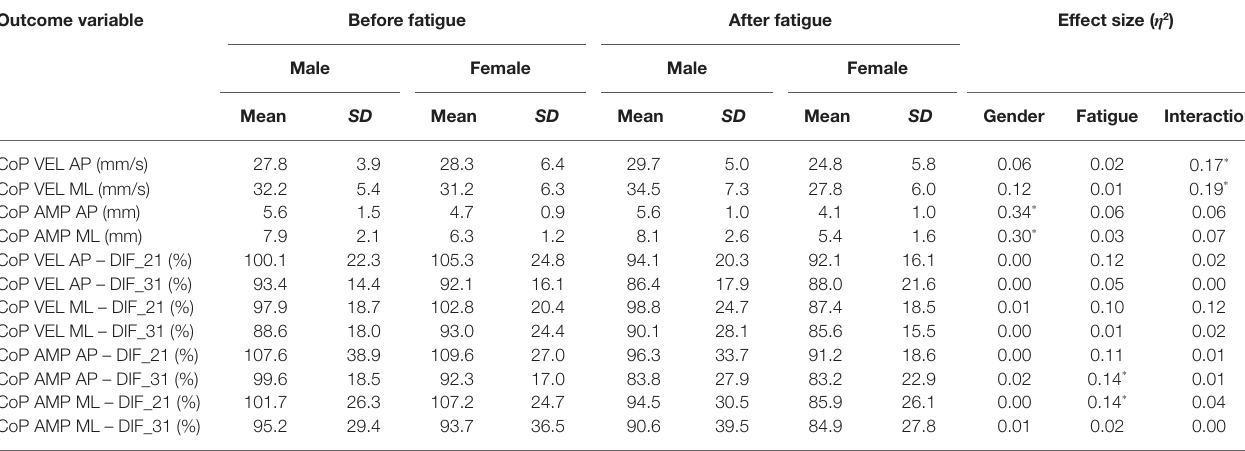
TABLE 1 | Postural sway variables and their transient behavior indexes before and after the fatiguing protocol. Outcome variable Before